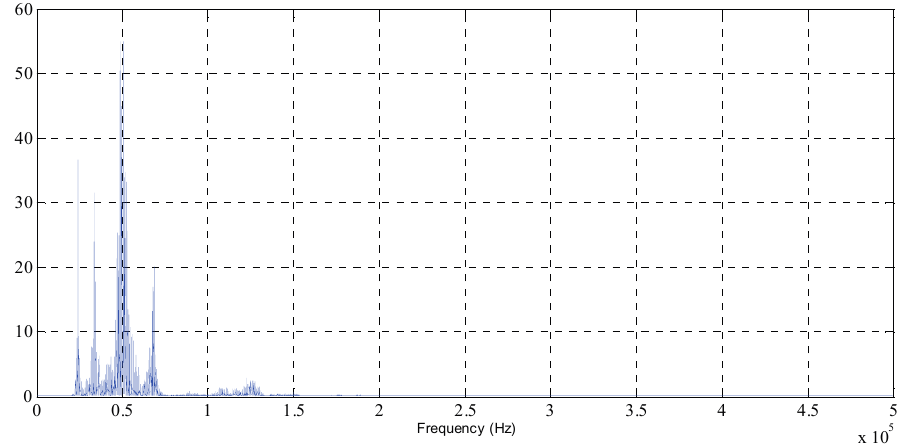
Figure 2. Fast Fourier Transform (FFT) power spectral plot at 0400 acquisition (session 1).